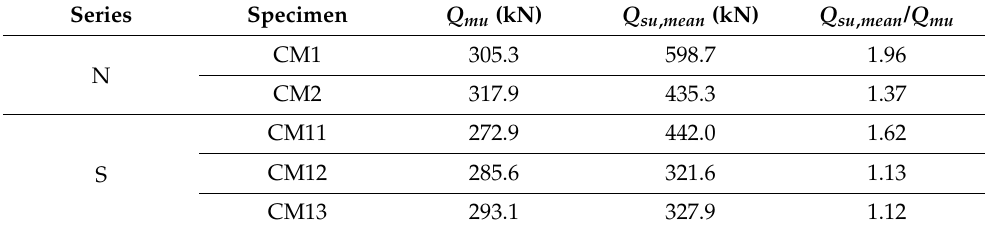
Table 5. Strength calculation